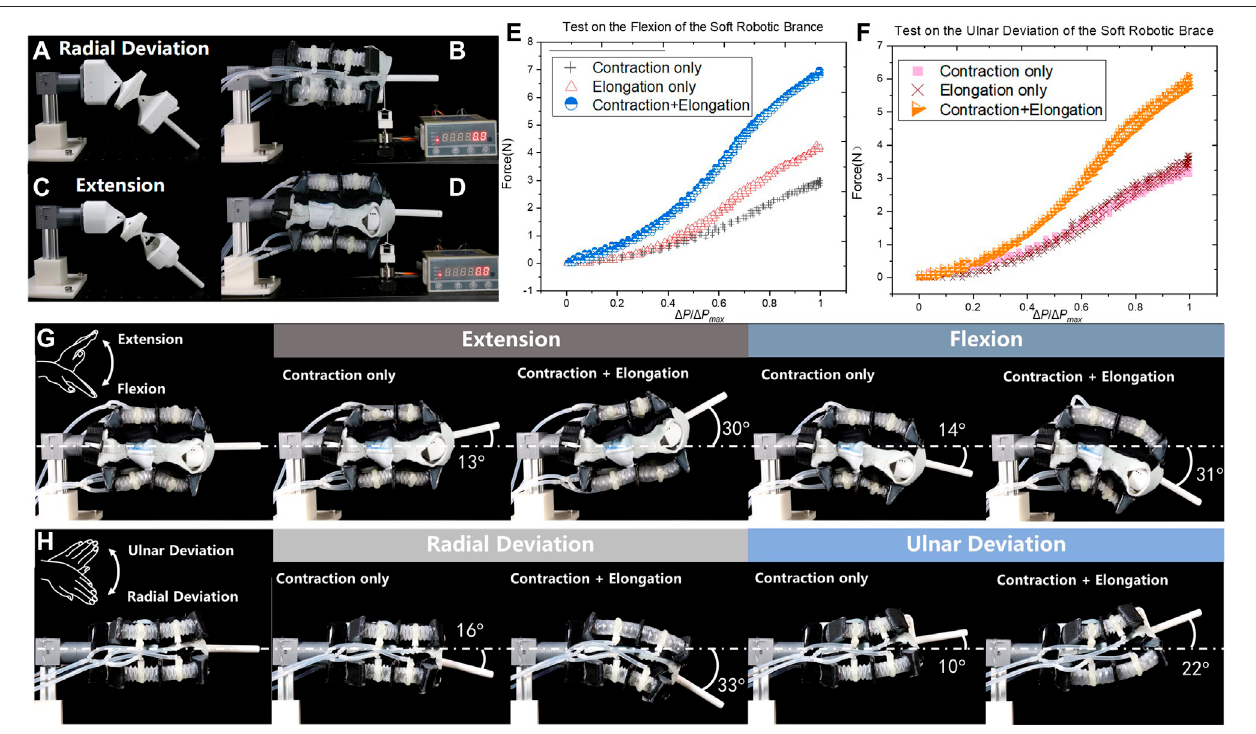
FIGURE7| Testsonthebrace, (A) thetestrigfor (B) theoutputforcetestinradialdeviation; (C) thesetupfor (D) theoutputforcetestinextension,theresultsofthe testswereplottedin (E) and (F) ;therangesofmotionsusingcontraction-onlyandsynergisticactuationapproachwerecompared in (G) extension/ fl exionand (H) radial/ ulnar